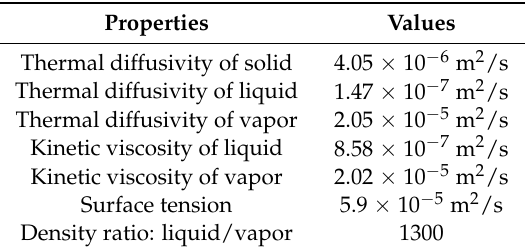
Table 2. Physical properties of the conducted simulations.